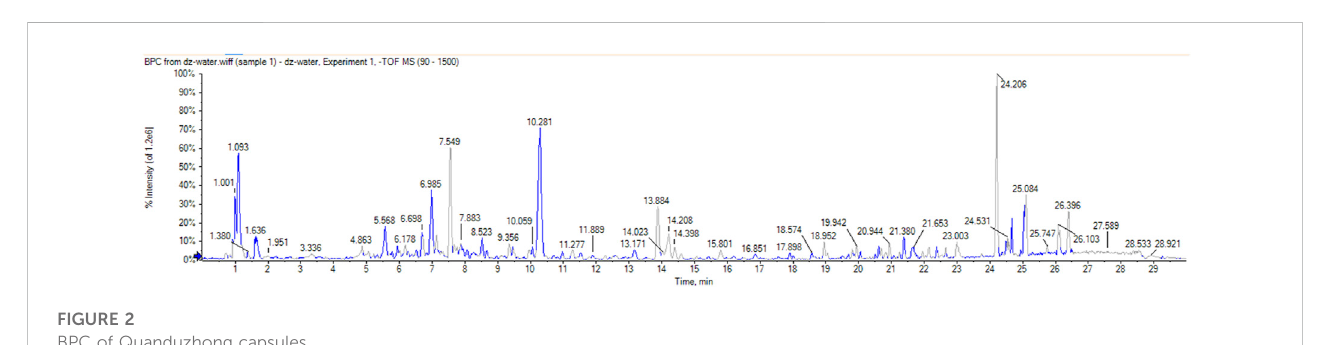
FIGURE 2 BPC of Quanduzhong